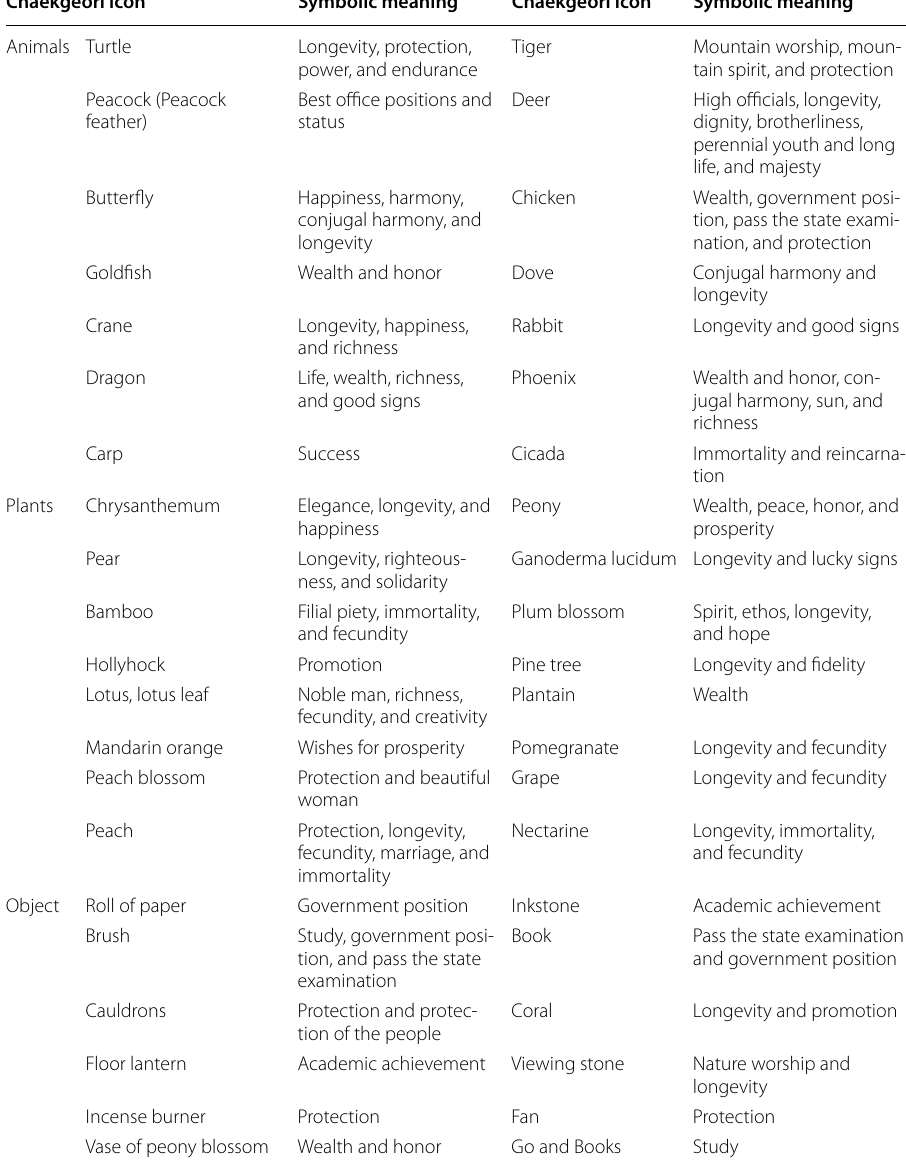
Table 1 Symbolic meanings of Chaekgeori